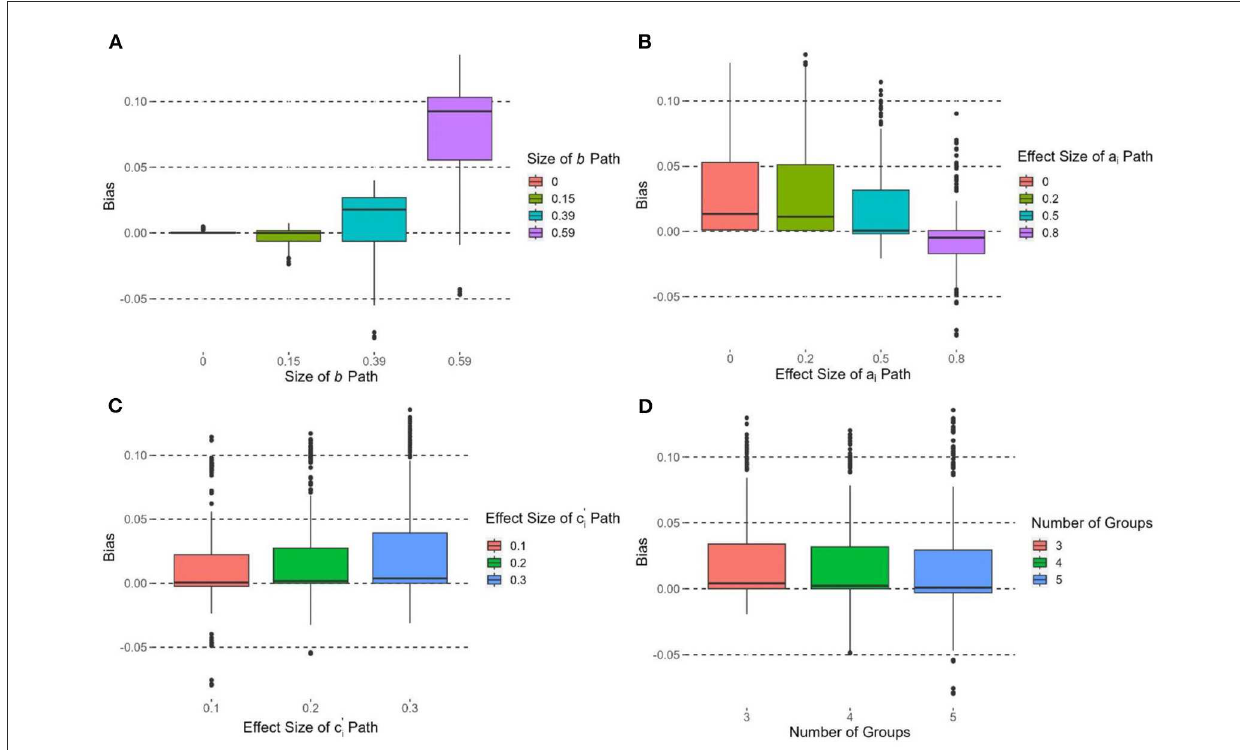
FIGURE3 Boxplots of bias of ˜ υ OPE grouped by (A) size of b path, (B) effect size of a i path, (C) effect size of c ′ i path, and (D) number of